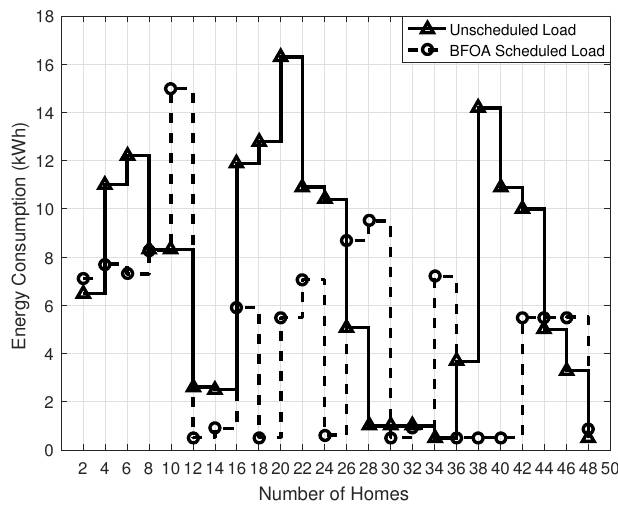
Figure 12. BFOA Energy Consumption.